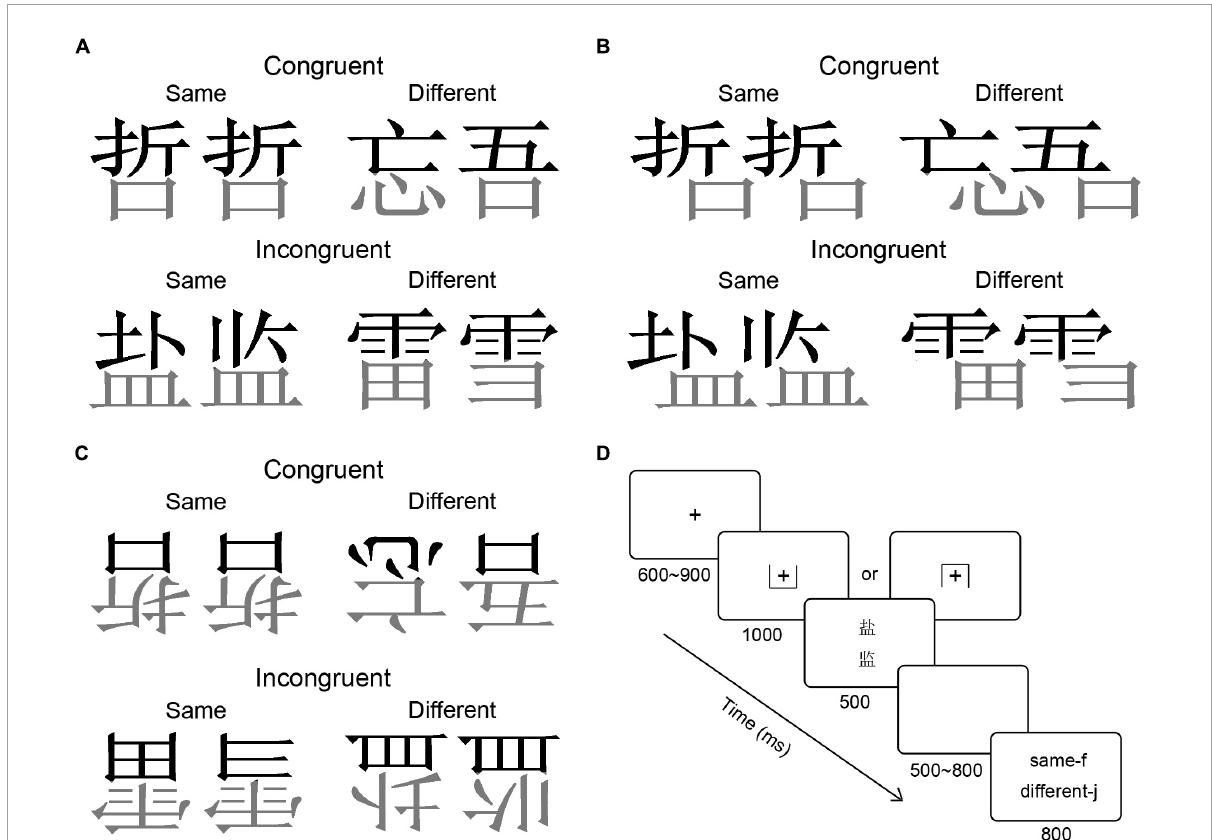
FIGURE1 Illustration of the stimulus pairs in the composite paradigm [ (A) for upright Chinese characters, (B) for misaligned Chinese characters, and (C) for inverted Chinese characters] and the schematic representation of the experimental procedure (D) .